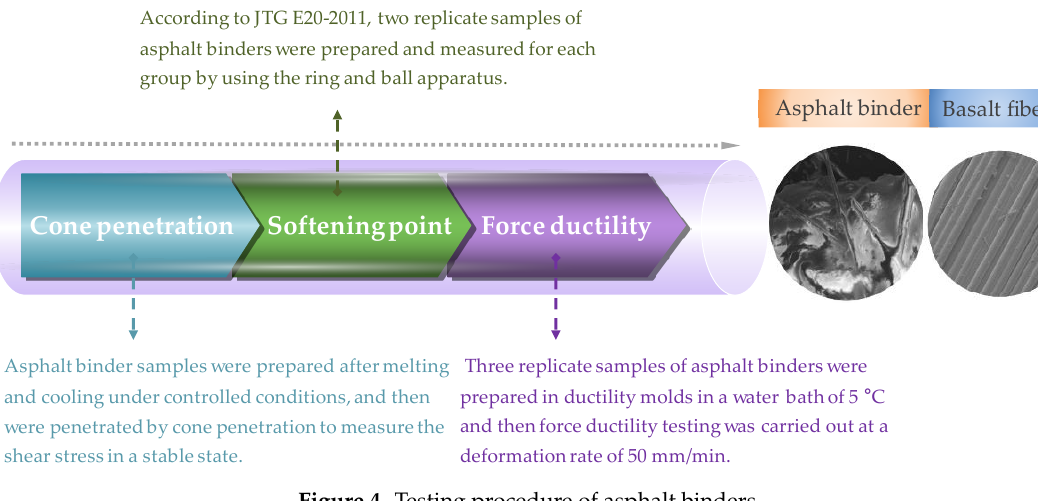
Figure 4. Testing procedure of asphalt binders.